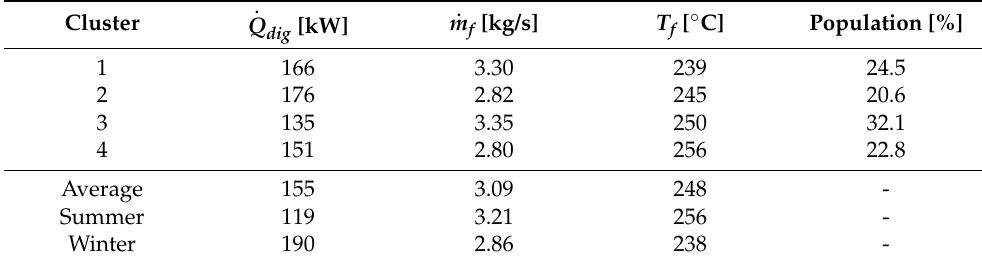
Table 2. Centroids and population scores for the four-cluster partition. . Cluster Q dig